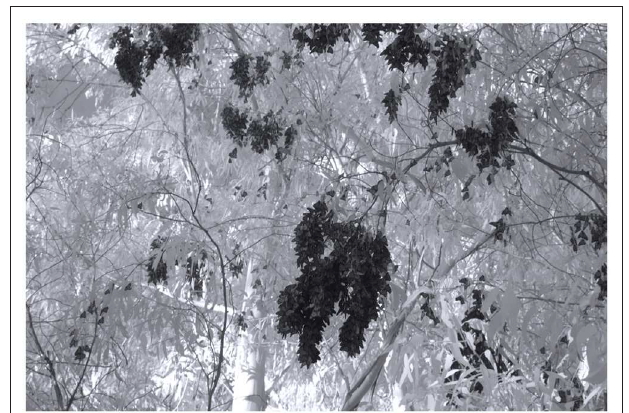
FIGURE 12 | A reflective IR photograph of a cluster of monarch butterflies at Pismo Beach State Park Monarch Butterfly Grove, California, showing the absorption of monarchs in the IR part of the electromagnetic spectrum. This effect has potential to be used to identify visually clusters of monarchs in complex environments and thus aid computer vision